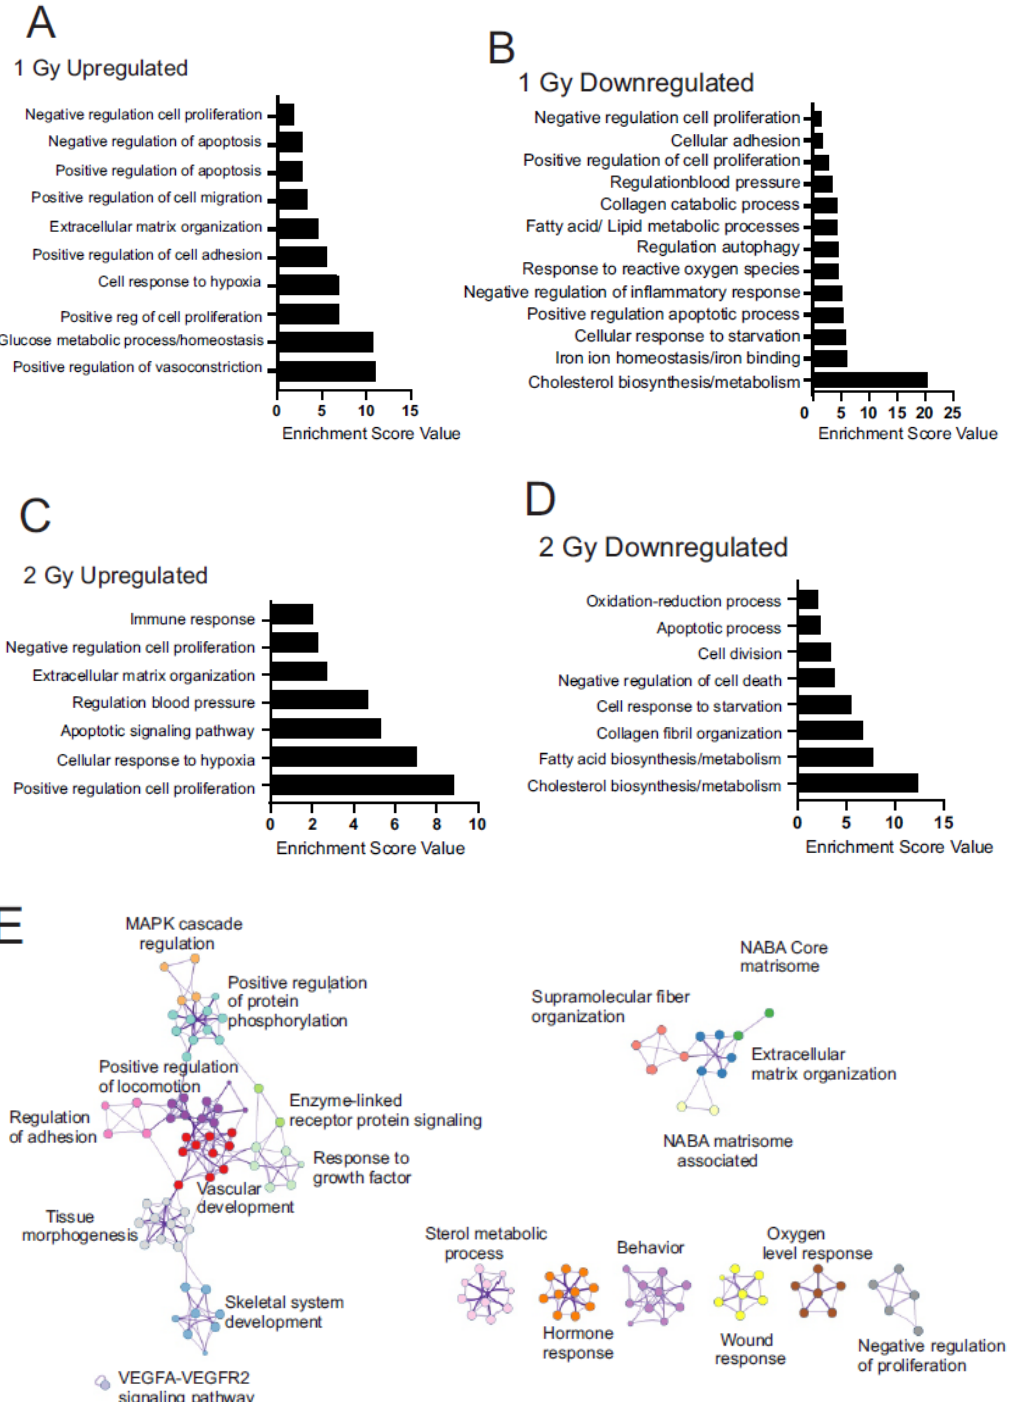
Figure 3. GO term cluster, KEGG pathway enrichment, and Metascape analyses of differentially expressed genes in MSCs following chronic low dose-rate irradiation. MSCs were grown to 60% confluence and exposed to 60 Co irradiation at 0.66 cGy/h for 1 Gy (1 week) or 2 Gy (2 weeks). Control cells were cultured under identical conditions for 1 or 2 weeks. Irradiated and control cells were lysed at the same time, and RNA was prepared for RNAseq. Pathway regulation was compared for all conditions. A,B. 1 Gy irradiation, upregulated pathways ( A ) and downregulated pathways ( B ). C,D. 2 Gy irradiation, upregulated pathways ( C ) and downregulated pathways ( D ). ( E ). Clustered GO terms using Metascape using genes with q < 0.05 to visualize pathway relationships.